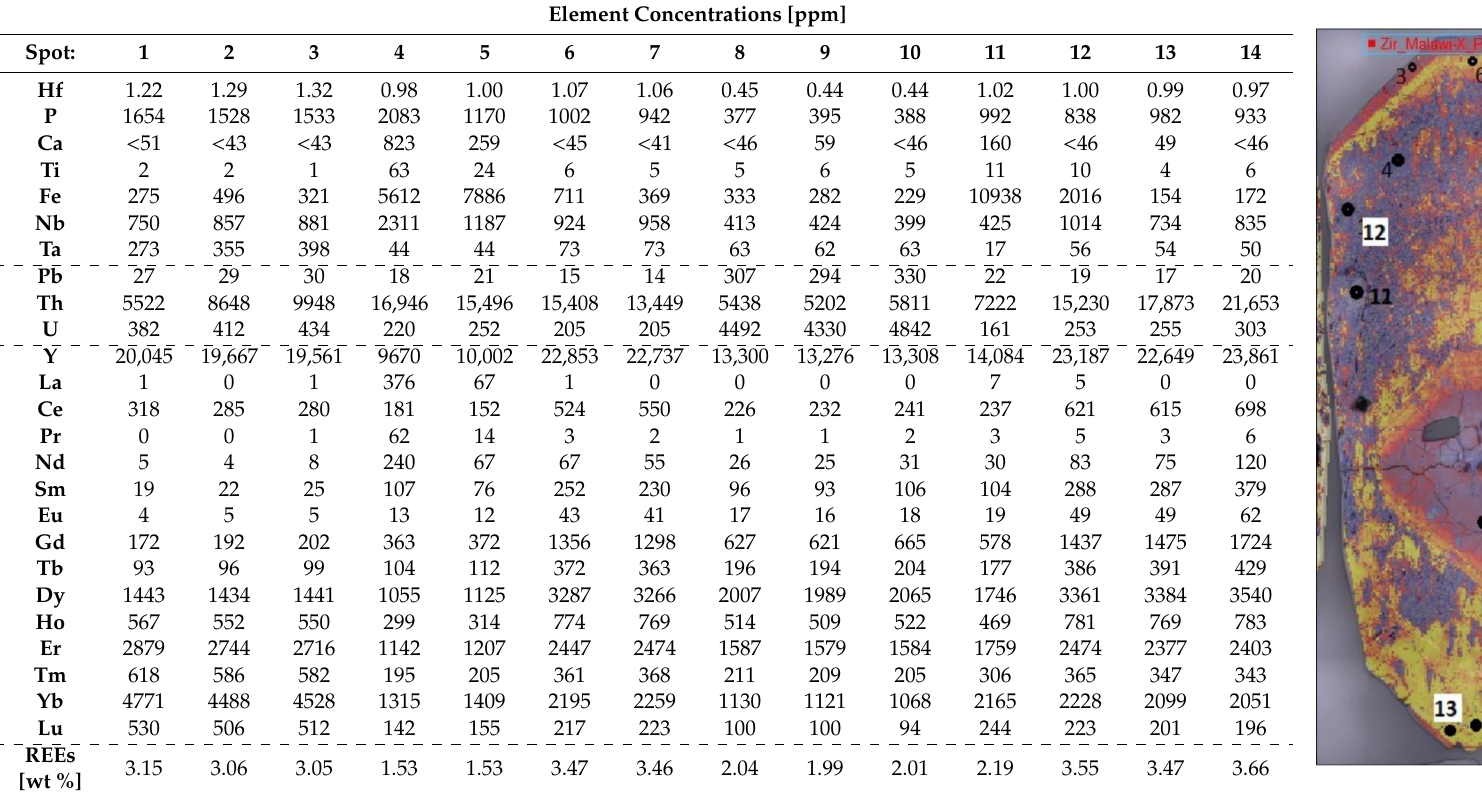
Table A7. Trace-element concentrations from multiple spot measurements on zircon sample MalawiX from Mt. Malosa, Malawi as obtained by LA-ICP-MS (given in ppm, except for Hf and REE totals that are given in wt. %; totals of REEs comprise Y + La to Lu). Note, that measurement spots for trace-elements di ff er from those chosen for U-Pb isotopic dating (Table A5 and Figure 7a). Spot locations are indicated in a PL hyperspectral map with the integrated intensity of the Dy 3 + signal given color-coded.